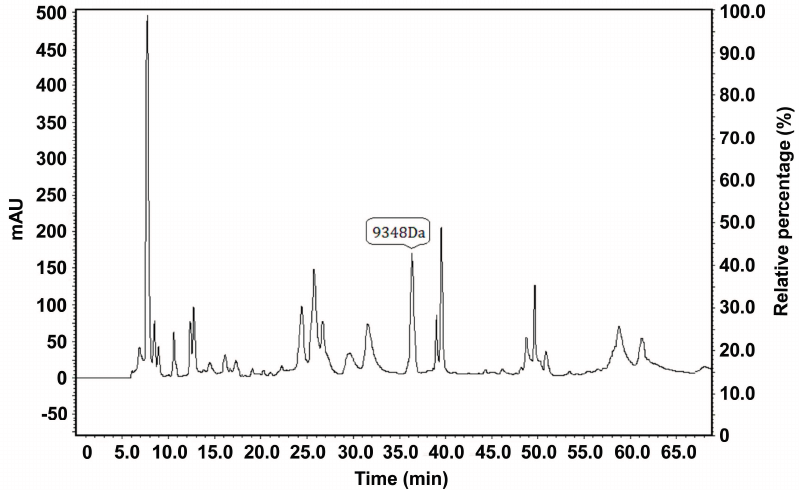
Figure 3. Isolation and purification of the proteins or peptide segments with an m / z of 9348 Da by HPLC. MALDI-TOF-MS confirmed that the sample eluted at minutes 36 and 37 contained the proteins with an m / z of 9348 Da.